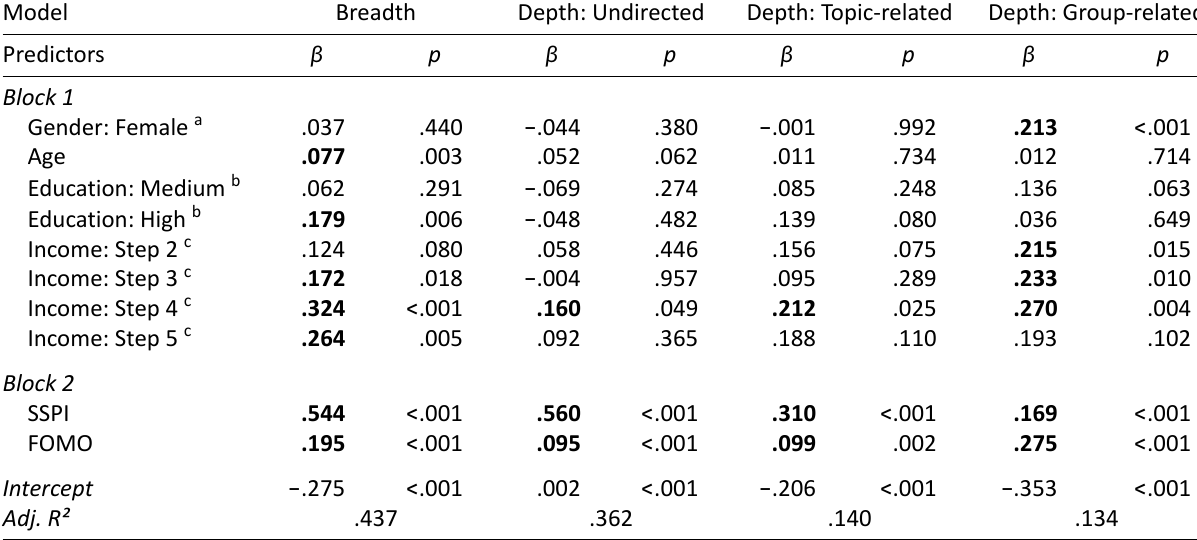
Table 1. Linear regression models predicting self‐concepts of informedness among social media users.